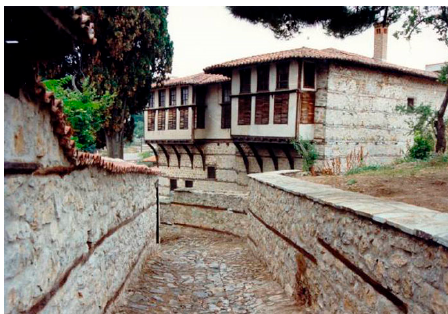
Figure 1. Façade of “Manousis” mansion.